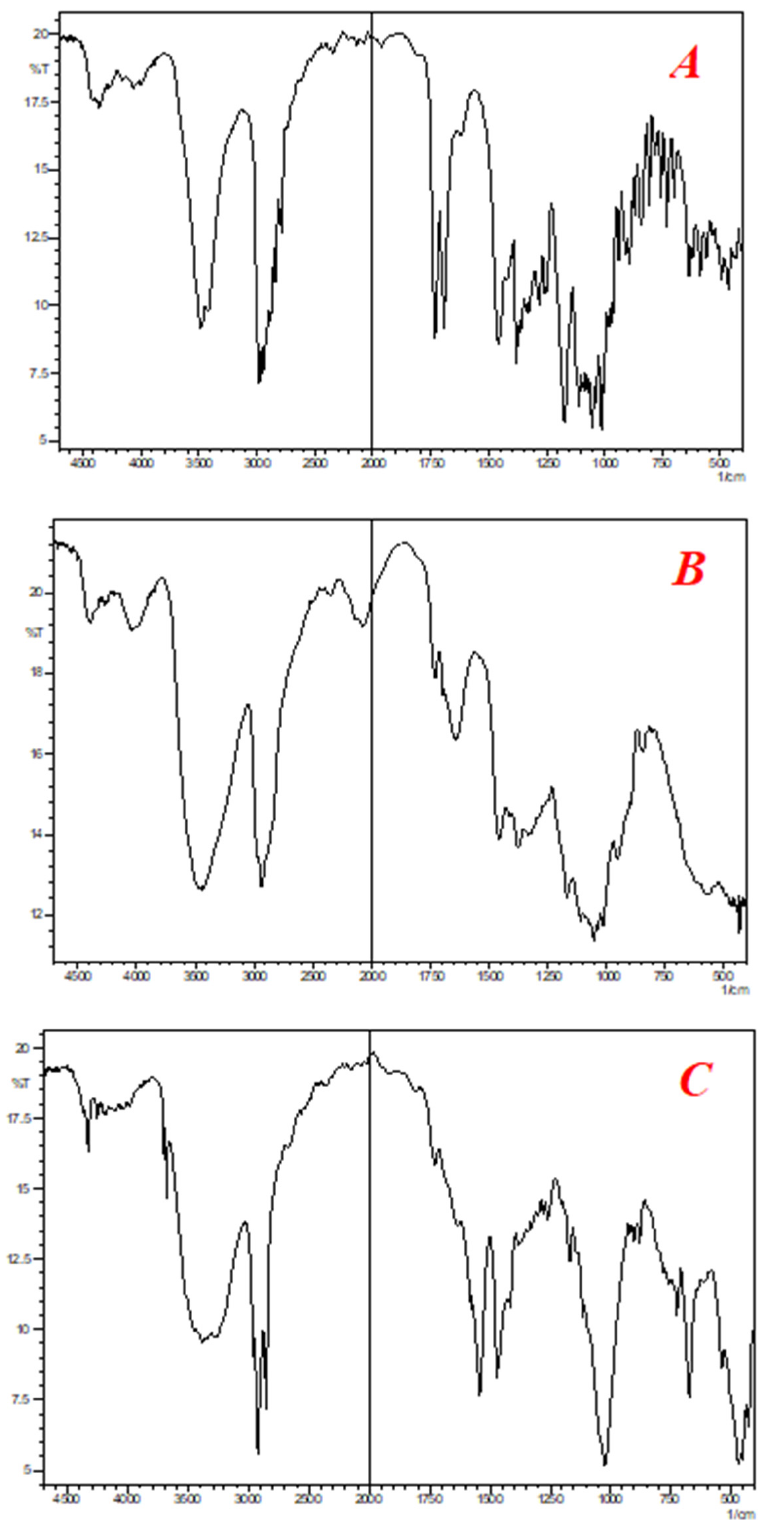
Figure 2. FTIR Spectra of ( A ) clarithromycin, ( B ) HPMC, and ( C ) sustained-release matrix tablets of clarithromycin.